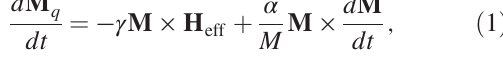
ffiffiffiffiffiffiffiffiffiffiffiffiffiffiffiffiffiffiffiffiffiffiffiffi p ffiffiffiffiffiffiffiffiffiffiffiffi τ Þ − 1 1 − ð ω 0